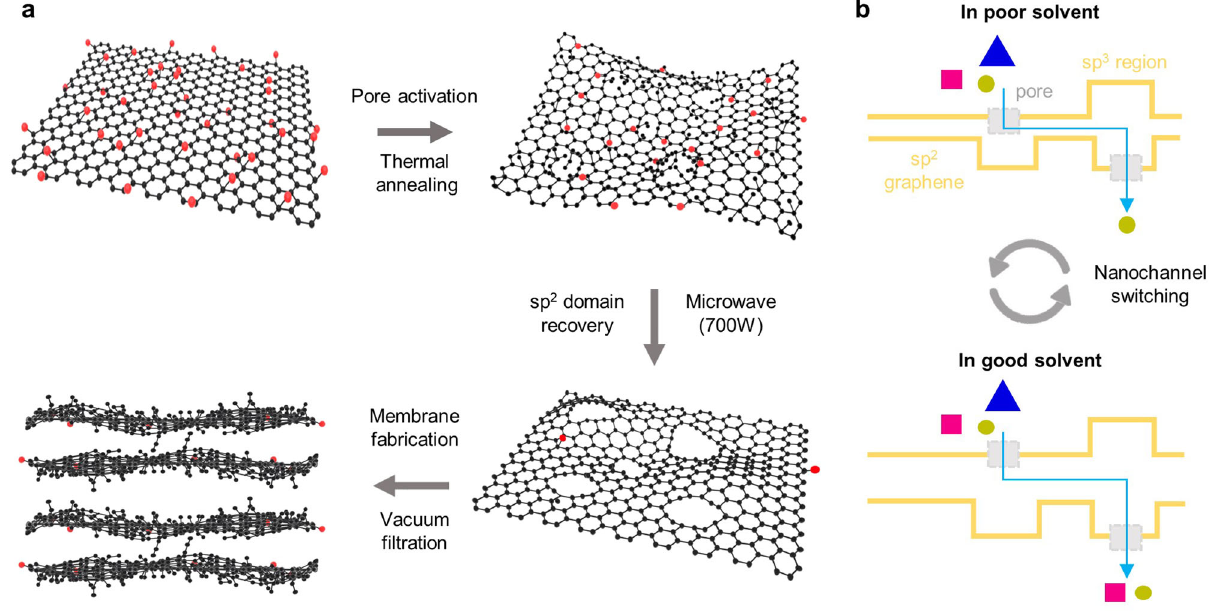
Fig. 1 | Microwave-assisted designofnanoporousgraphene membrane.a Preparationofsp 2 carbon enriched nanoporous multilayer graphene membrane enabled by microwave-assisted reduction. b Membrane working principle for switchable molecular separation in response to solvent